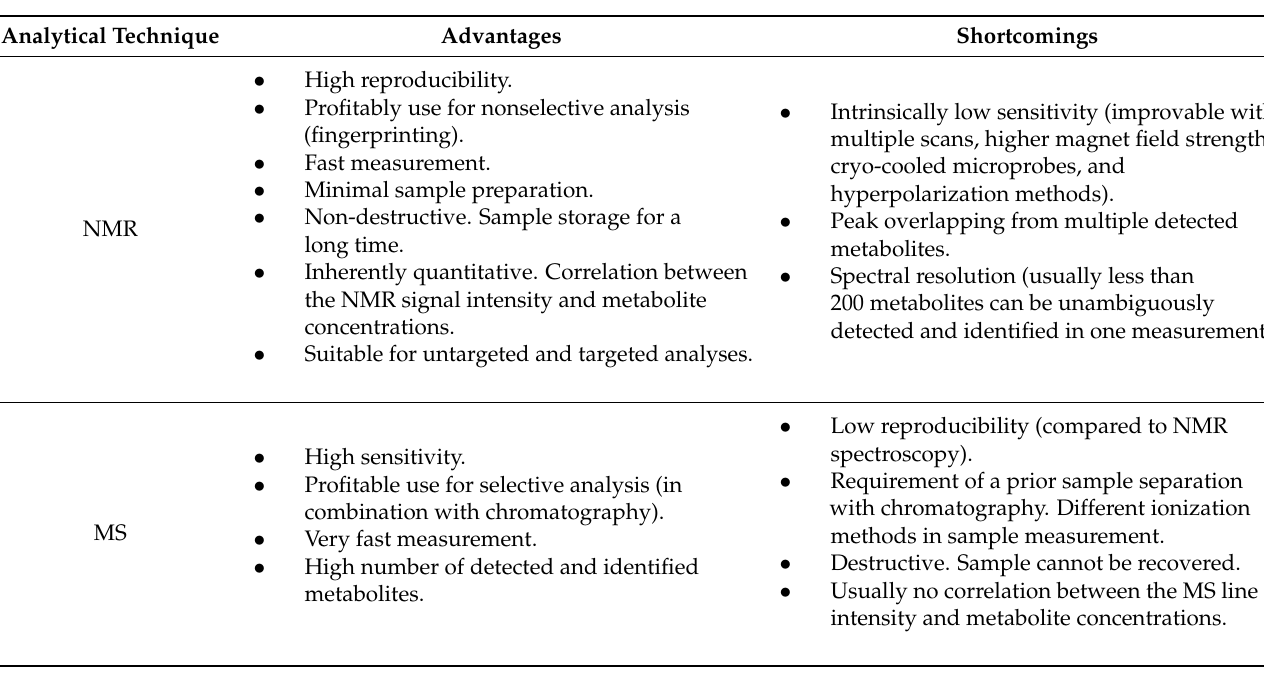
Figure 1. Comprehensive mechanism-based scheme summarizing the application of NMR and MS techniques associated with chemometric tools in the specific subject of EVOOs’ geographical origin analysis. Table 1. Summary of the most important advantages and shortcomings of NMR and MS techniques [42,43].